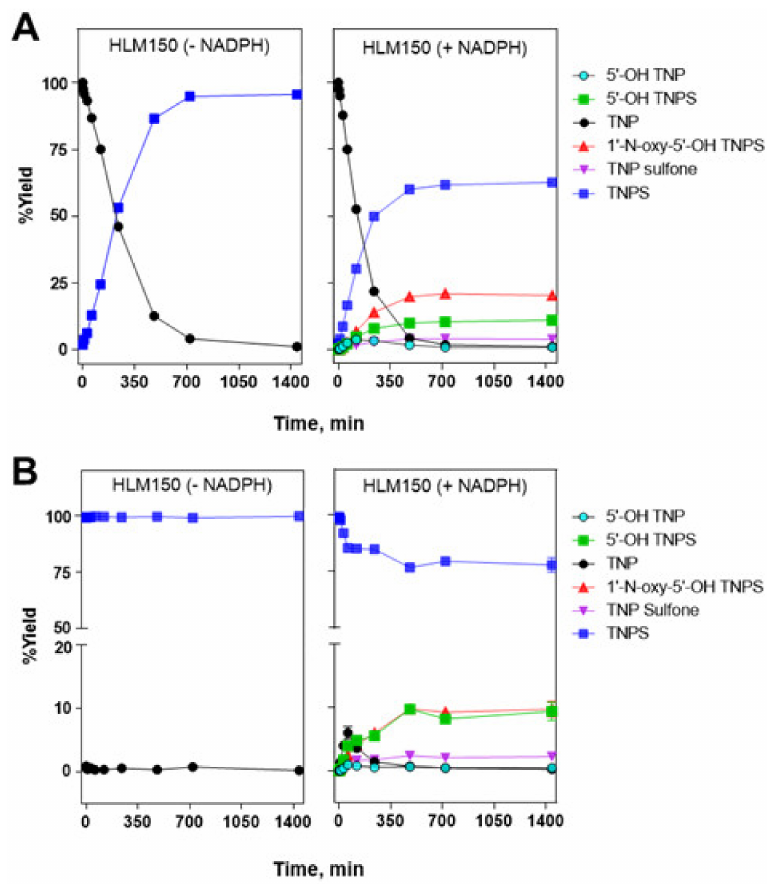
Figure 5. Time course profiles of oxidation of tenatoprazole ( A ) and tenatoprazole sulfide ( B ) by HLMs. Each substrate (500 µ M) was incubated with HLMs for the indicated times in the absence of NADPH ( left panels) and the presence of NADPH ( right panels). The values are shown as the means ± SD of triplicate determination. Tenatoprazole and tenatoprazole sulfide are labeled as TNP and TNPS, respectively, as shown at Figure